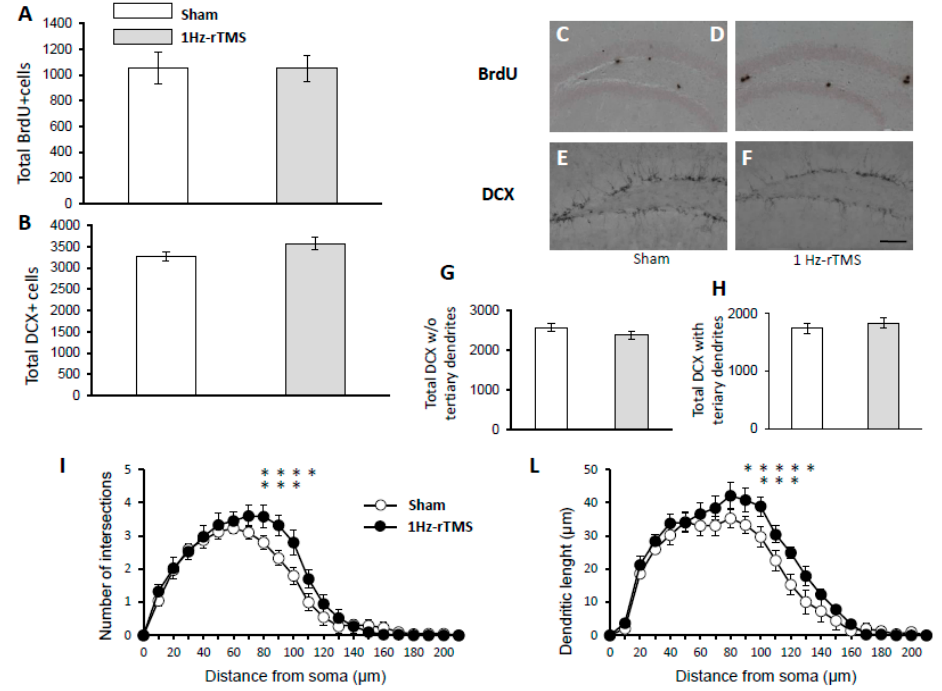
Figure 4. 1-Hz rTMS, neurogenesis, and dendritic complexity of newly generated neurons. ( A , B ) The number of thymidine analogue bromodeoxuridine (BrdU)-incorporated cells was not significantly different in the granular cell layer (GL) between Sham- and 1Hz- rTMS-stimulated mice. ( C – F ) Representative images of BrdU and Doublecortin (DcX) + neurons. Scale bar, 200 µ m. Quantification of DcX + cells without ( G ) and with tertiary dendrites ( H ). ( I , L ) Dendritic length and intersections in newly generated granule cell are increased in the 1-Hz rTMS-treated mice. Data are reported as mean ± SE, n = 5 in both groups; 5 cells each mouse. * p < 0.05. ** p < 0.01.